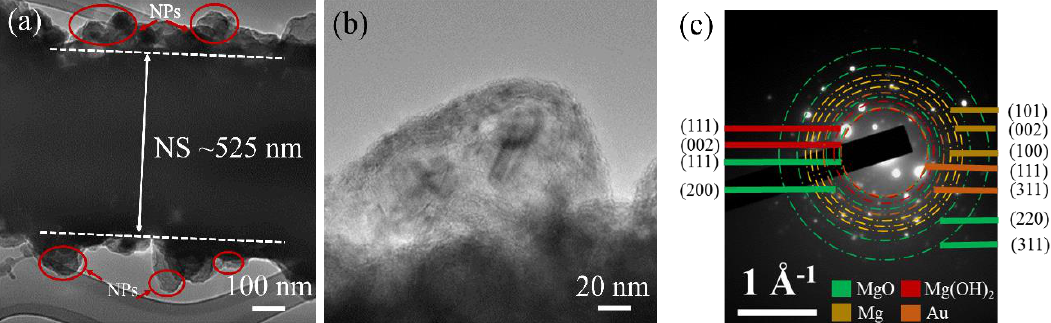
Figure 6. ( a ) TEM micrograph of a silica NS, where red circles indicate Mg nanocrystals (NC) on the surface. ( b ) A high-resolution TEM micrograph of a Mg NC and ( c ) the corresponding SAED pattern consisting of rings of h-Mg (gold) and the c-MgO (green).